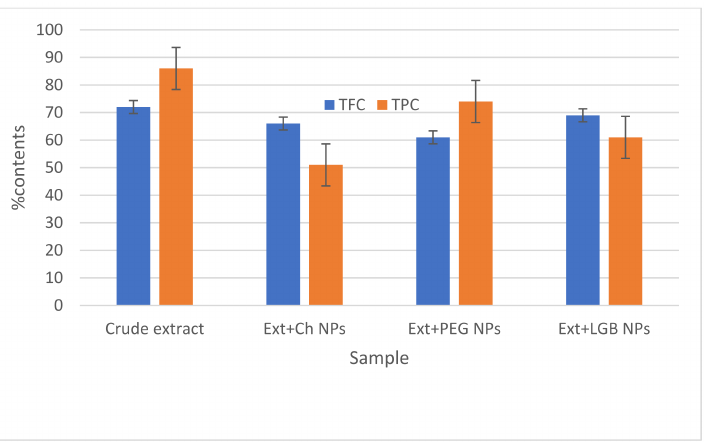
Figure 1. % TFC and TPC in Indigofera linifolia crude extract, Ext+Ch NPs, Ext+PEG NPs, and Ext+LGB